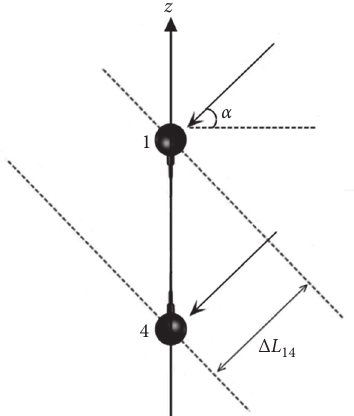
Figure 8: Estimation of elevation angle for spatial direction vector.